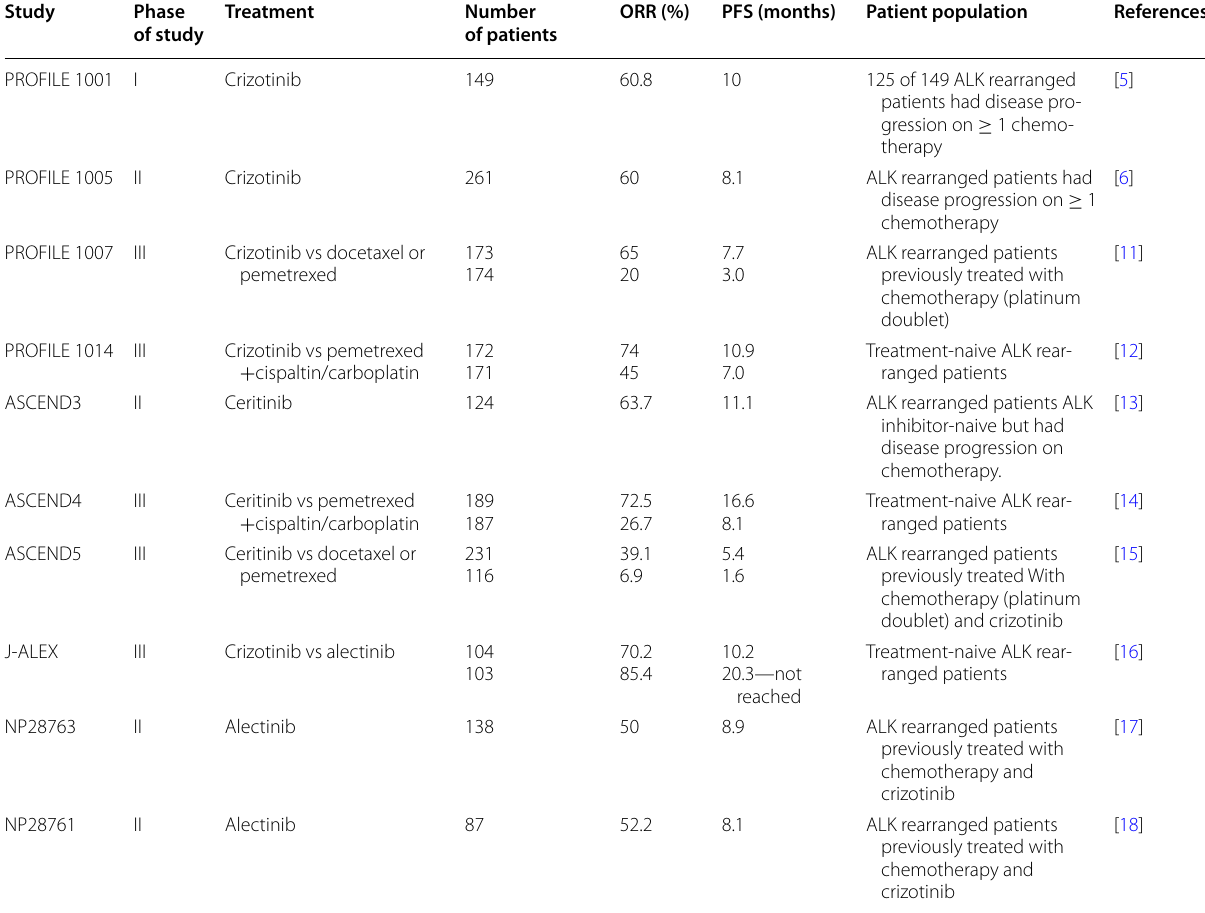
Table 1 Trials about the efficacy of first- and second-generation ALK inhibitors Study Phase of study